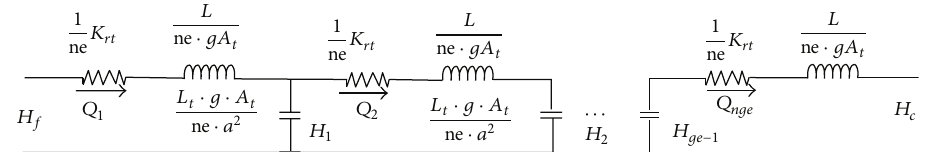
Figure 3: Scheme of the headrace tunnel model.